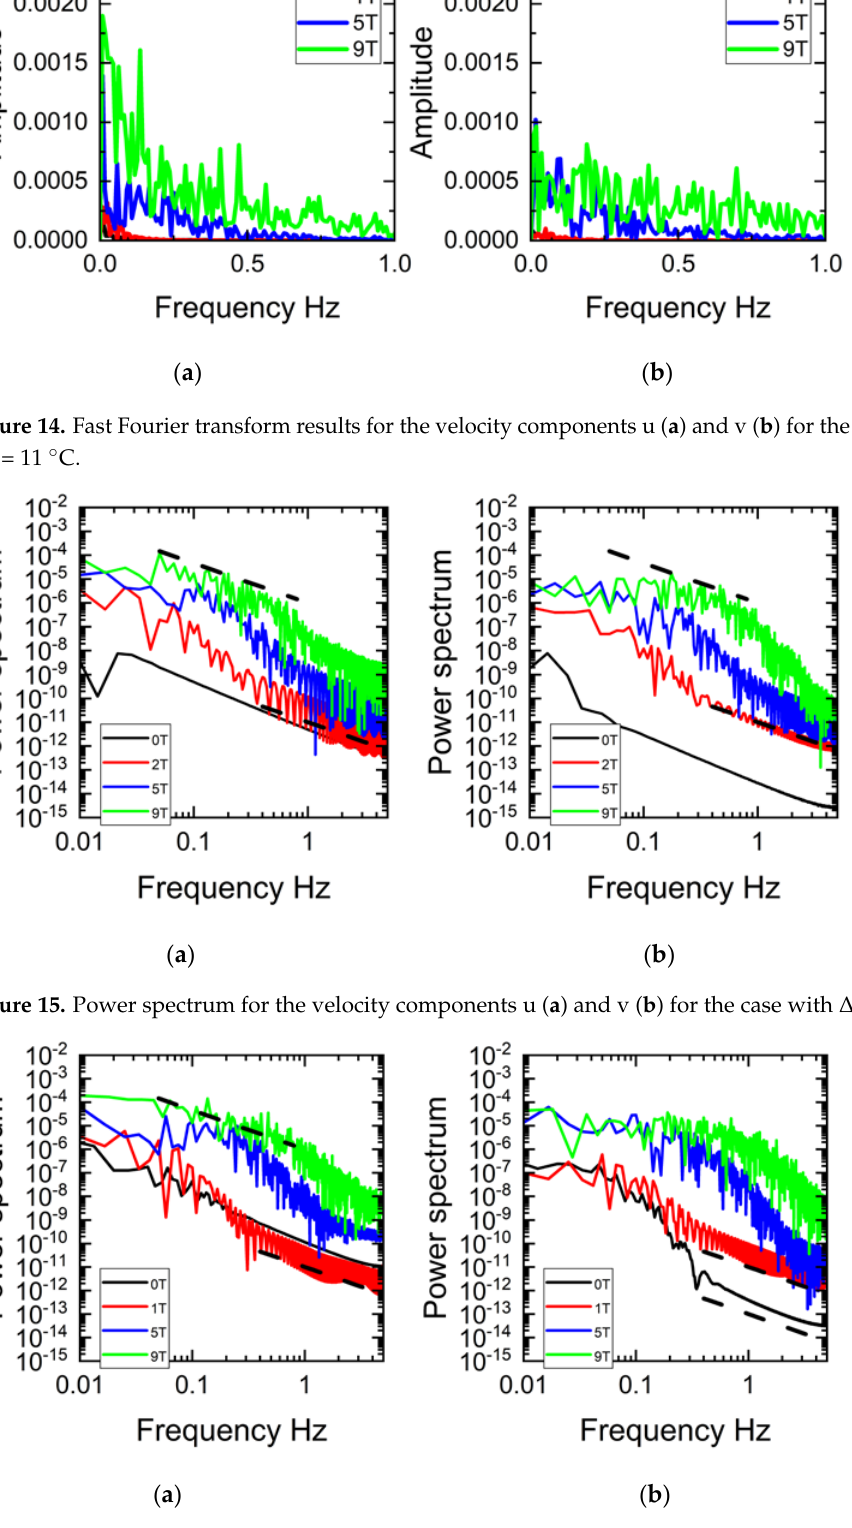
Figure 16. Power spectrum for the velocity components u ( a ) and v ( b ) for the case with ΔT = 11 °C . Figure 13 presents amplitude versus frequency for the numerical analyses for the horizontal (u) and vertical (v) components of the velocity for the temperature difference of 5 °C. For the neutral case there are no visible peaks on the graphs, suggesting that the flow is steady and laminar. For b 0MAX = 2T, two characteristic frequencies with low ampli- tudes can be observed (0.0083 Hz and 0.0249 Hz). A further increase of the imposed mag- netic induction shows a growing amplitude tendency, with the maximum magnitude of amplitude for b 0MAX = 9T. Specific frequencies for this case are 0.0083, 0.1332, 0.1998 Hz and 0.0083, 0.0249, 0.1748 Hz for the horizontal and vertical parts, respectively. For the higher temperature difference results, presented in Figure 14, one visible peak for the neutral case can be observed for the horizontal velocity (0.0066 Hz). After applying magnetic induction to the system, four characteristic frequencies can be observed for b 0MAX = 1T: 0.0083, 0.0249, 0.0499, and 1.3484 Hz. A further increase of the imposed magnetic induction shows a growing amplitude of the observed peaks and a tendency to widen the spectrum—a more continuous spectrum with a wide range of specific frequencies—this is a phenomenon typical of a well-developed turbulence. The power density of the velocity is shown in Figures 15 and 16. For the smaller tem- perature difference between the thermally active walls (Figure 15) for the natural convec- tion case, the energy spectrum of the both velocity components has an almost linear type. This specific behavior changes with the application of the external magnetic field and with the temperature—as for b 0MAX = 0T and Δ T = 11 °C (Figure 16) the power density function is no longer smooth. For higher magnetic inductions, as the flow changes its character from laminar to turbulent, the energy spectrum functions have more ragged characters. It is also visible that with the increase of the magnetic induction and the increasing velocity of the fluid, the power density function is shifting towards higher energies. The inertial range is elongated and the function lines tend to bulge slightly. For lower values of the magnetic inductions and higher frequencies, a good match to the − 5/3 exponent law (the dashed line) can be observed, especially for the transitional case (2T). This clearly indicates that the kinetic energy is transmitted from the larger scales to smaller vortices and then dissipated according to the Kolmogorov theory. Figures 17 and 18 presents selected temperature colormaps with fluid streamlines and normalized velocity vectors (for Δ T = 5 °C vector are scaled ×2 in comparison to the Δ T = 11 °C case). For the natural convection cases ( b 0MAX = 0T) for the smaller temperature difference, a small thermal plume of hot fluid on the middle-right part at the bottom and a cold fluid plume diagonally with up and downdrafts at the sidewalls can be observed along with the stream traces. The observed plumes have wide and thick stems with no